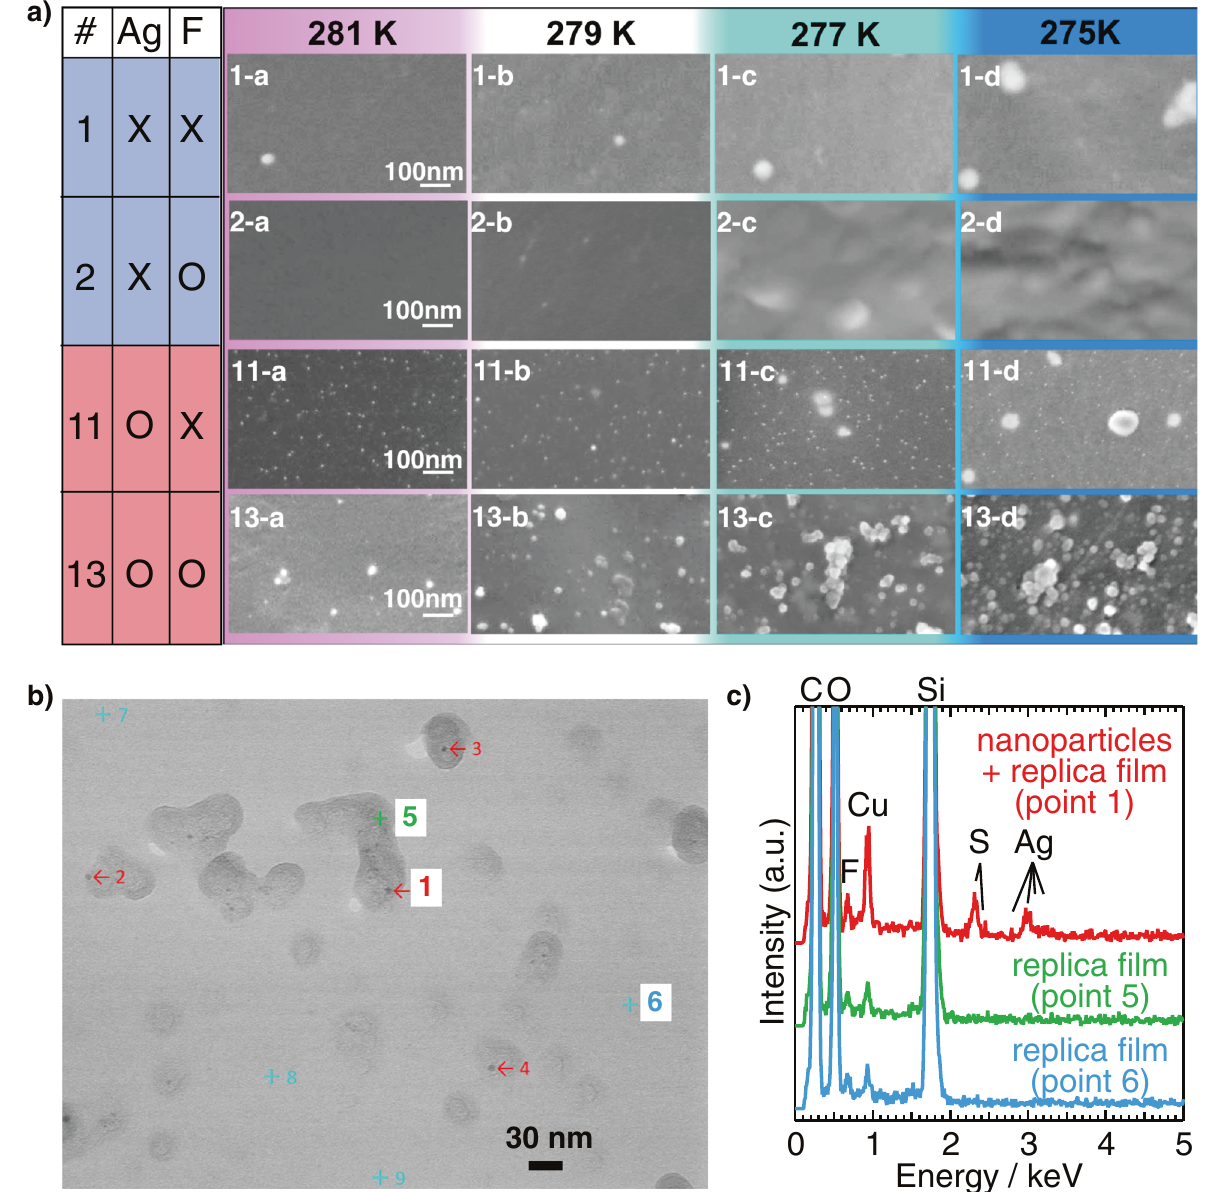
Fig. 3 Cluster formation of semiclathrate hydrate around silver nanoparticles. a HAADF-STEM image of replica fi lms prepared from samples #1, #2, #11, and #13 of TBA-3MP aqueous solutions listed in Fig. 1a. A number of silver nanoparticles smaller than 10 nm were observed in samples #11 and #13. b SE- STEM image (different area) of the same replica fi lm as “ 13-a ” in a . EDX measurements were performed at points 1-9. c Typical EDX charts at points 1, 5, and 6 in b . EDX charts of points 1 – 4 reveal the existence of silver nanoparticles incorporated in replica fi lm. Like enclosing silver nanoparticles, clusters of 10 – 30 nm were